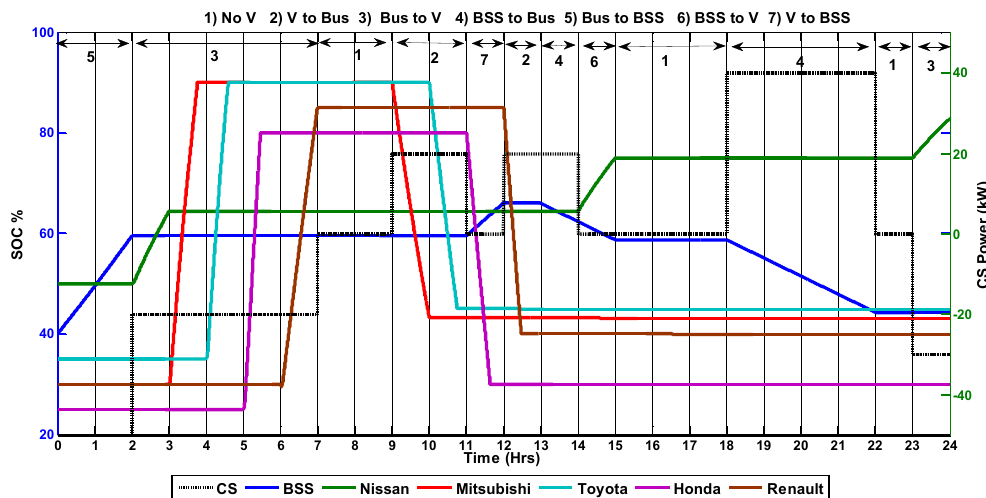
Figure 11. SOC of the BSS/PHEVs and CS power using the proposed PMS.